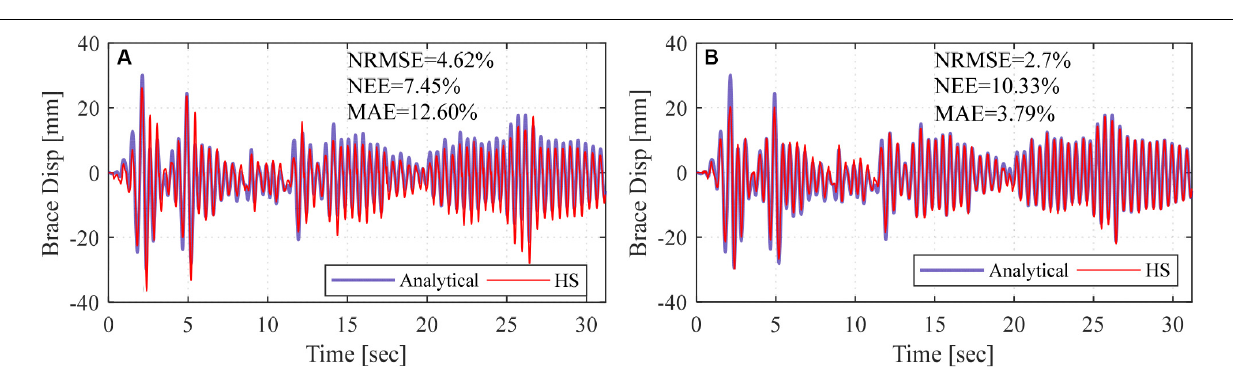
FIGURE 15 | Brace response from pure analysis and offline RTHS tests with deep LSTM network model located at high-performance computer cluster and trained using (A) 15 and (B) 20